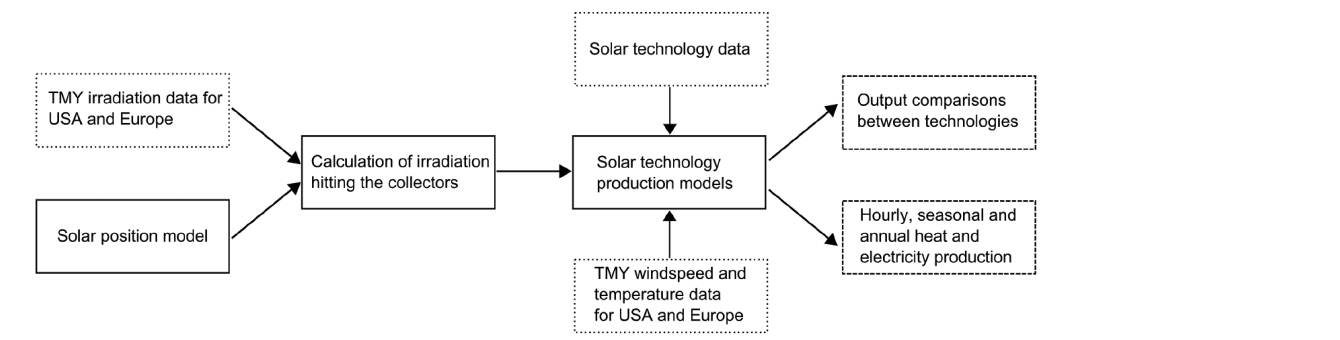
Figure 6. A flowchart of the methodology used for solar modeling.